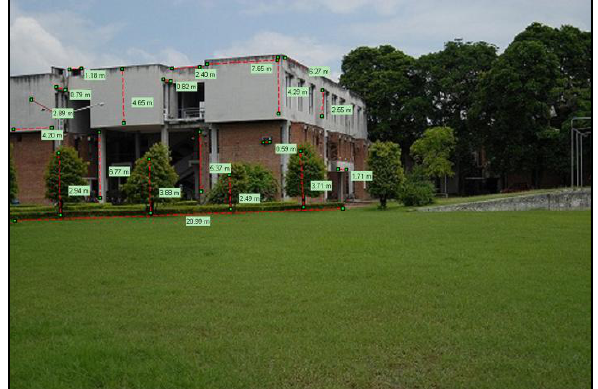
Figure 7. Dimensions of user selected points augmented over camera